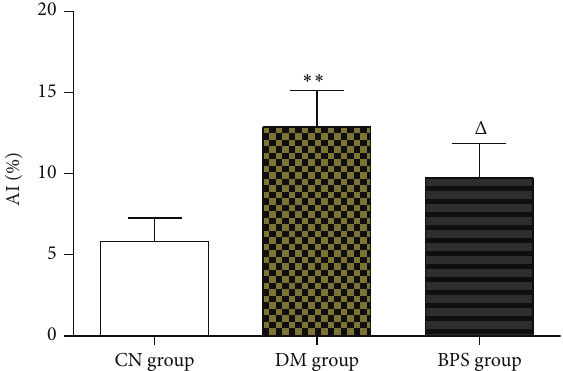
Figure 15: Apoptotic index. The DM group has the largest number ofpositivestainingcells.TheCNgrouphastheminimumnumberof positive staining cells ( 𝑃 < 0.01 ); compared with the DM group, the number of positive staining cells in the BPS group was significantly decreased ( 𝑃 < 0.05